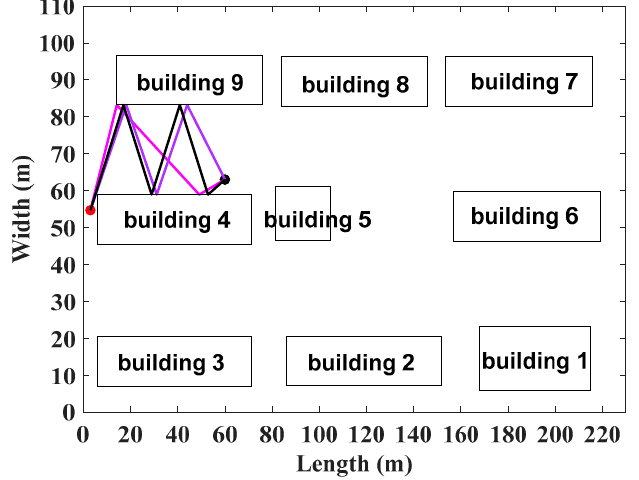
Figure 17. Visualization of the propagation path in a 2D surface at 60 m in the NLOS. Table 4. The RMSE in the NLOS.